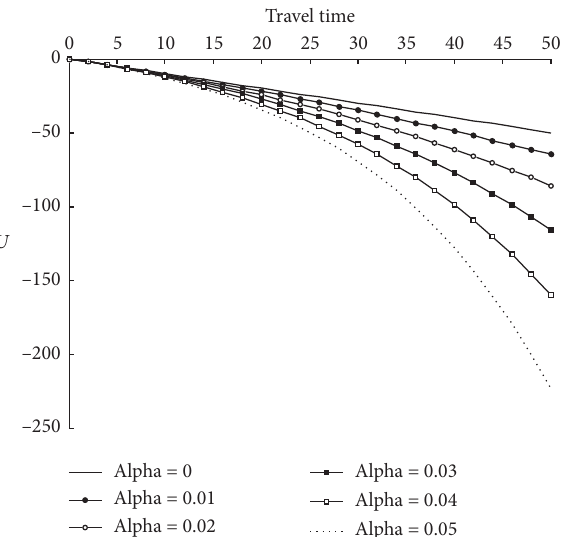
Figure 2: Influence of risk aversion on the utility with respect to travel times.